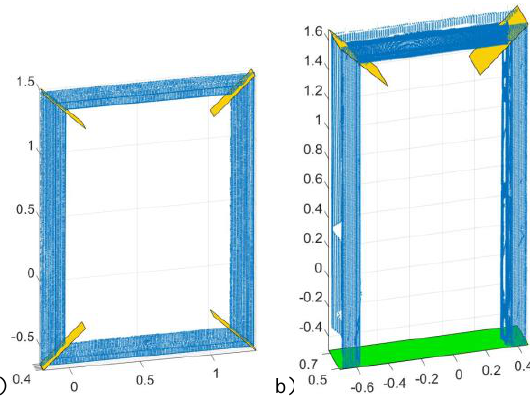
Figure 11. Window frame (a) and door jamb (b) represented with tilted planes on the corners The intersection points between firstly determined edges and the tilted plane they cross are then computed. Assuming that the edges of the next frame part are perpendicular to the previous ones, their direction is known. Hence the edges of this second part can be entirely determined, using the intersection points as centroids. This projection step is finally repeated for the remaining parts, leading to determination of all edges on each part of the frame. The successive intersections enable to obtain characteristic points on each corner (Figure 12), and they now need to be connected.